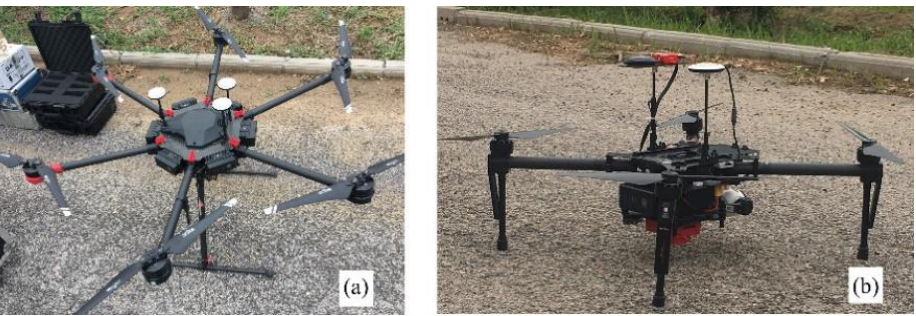
Table 5. Specifications of the two cameras used in this study.